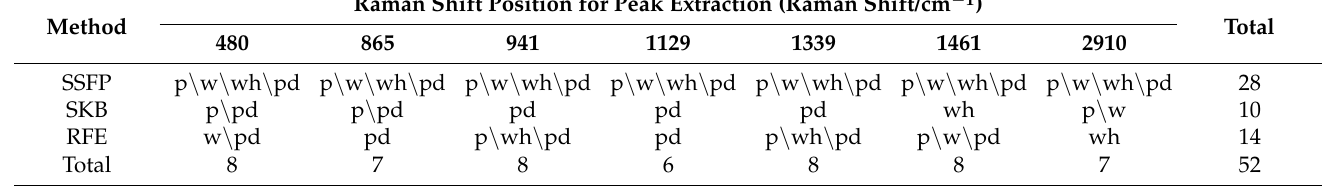
Table 3. Results of 3 feature information selection methods (p is prominences, w is width, wh is width_height, and pd is